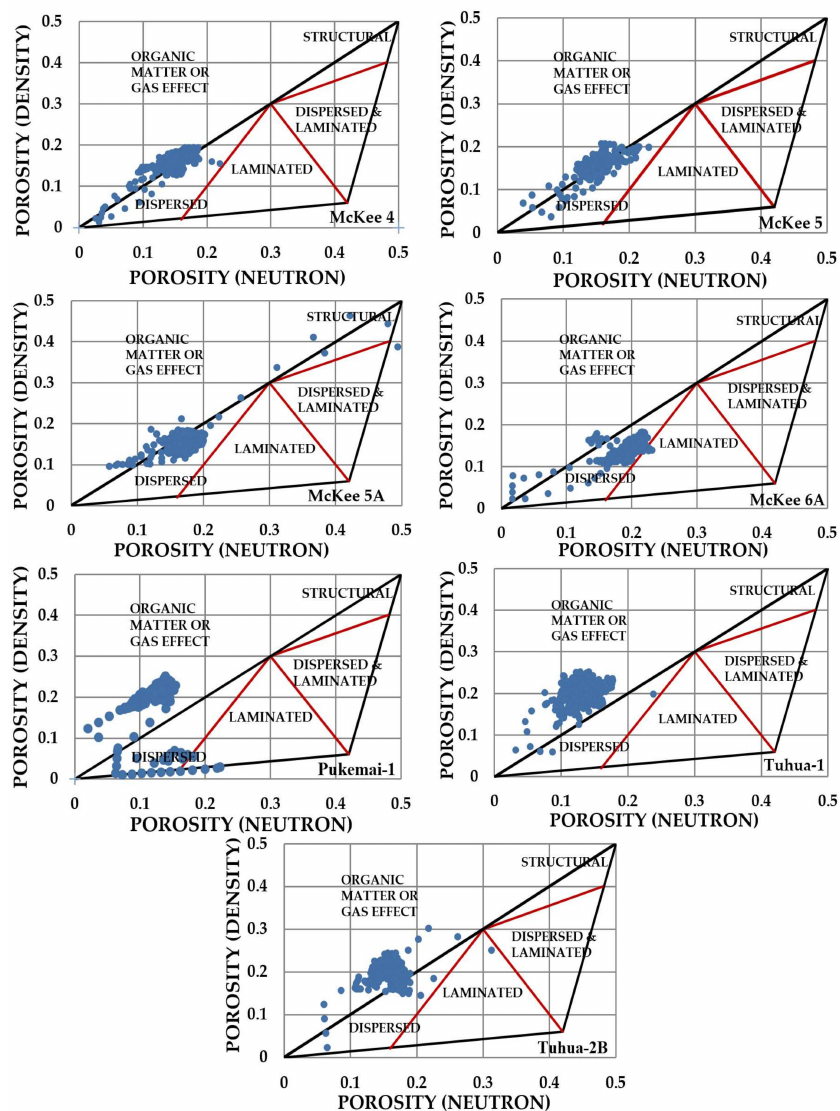
Figure 12. Density porosity (In decimal fraction) versus neutron porosity (In decimal fraction) showing the clay